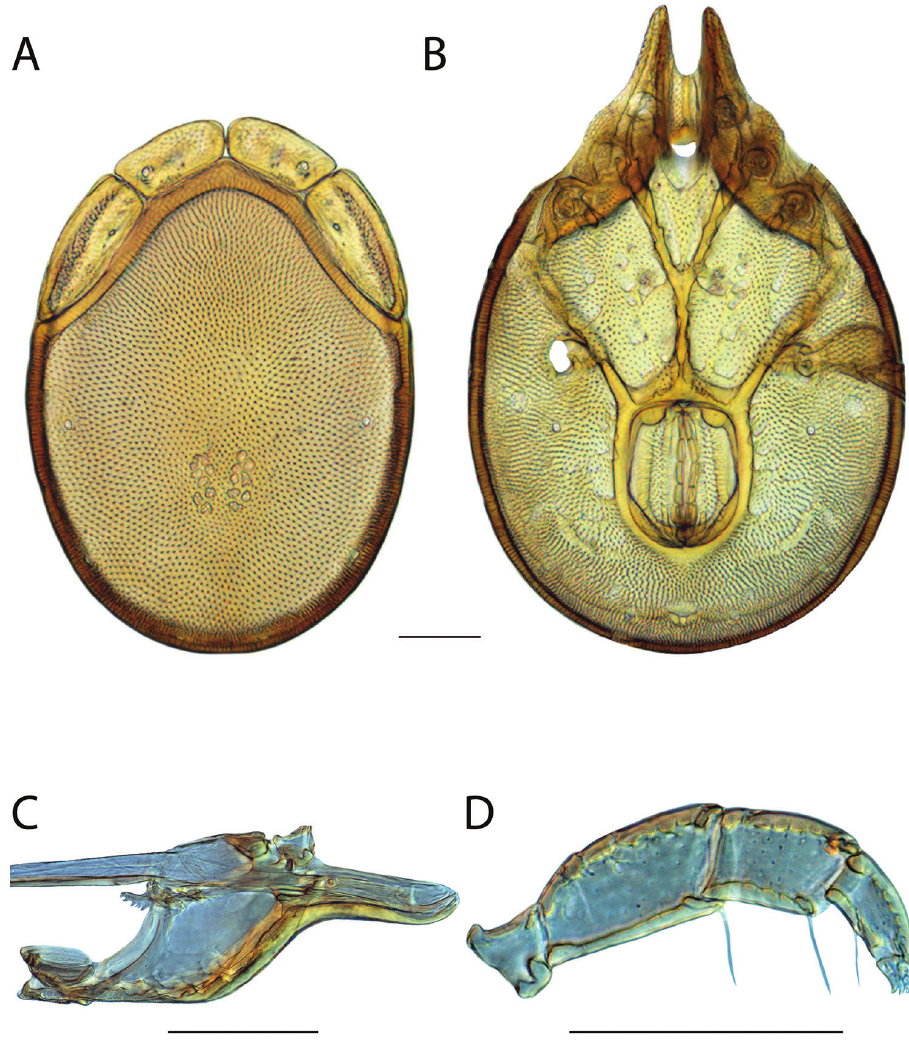
Figure 122. Torrenticola kurtvietsi male: A dorsal plates B venter (legs removed) C subcapitulum D pe- dipalp (setae not accurately depicted). Scale = 100